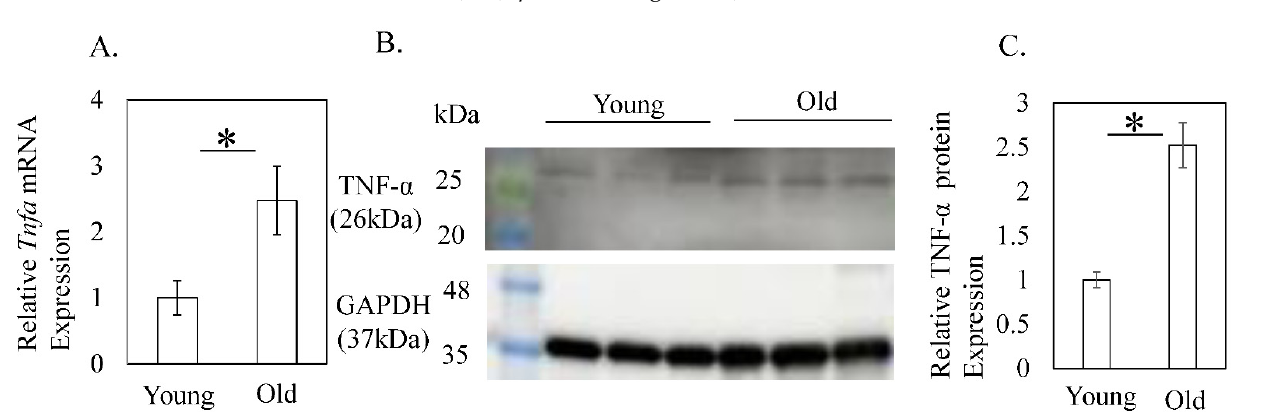
Figure 3. APJ − positive cells in the quadriceps femoris. ( A , B ) Dot plot analysis of CD45-negative myogenic cells. X -axis, Sca-1; Y -axis, APJ. ( C , D ) Ratio of APJ-positive cells among CD45-nega- tive/Sca1-negative cells © and CD45-negative/Sca1-positive cells ( D ) in young (3-month-old) and